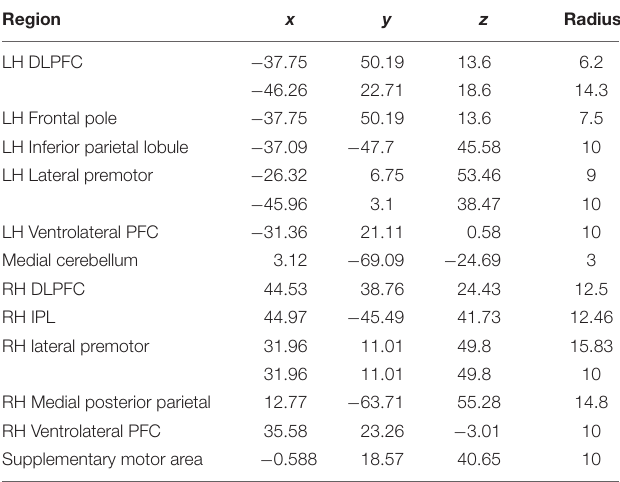
LH: left hemisphere; RH: right